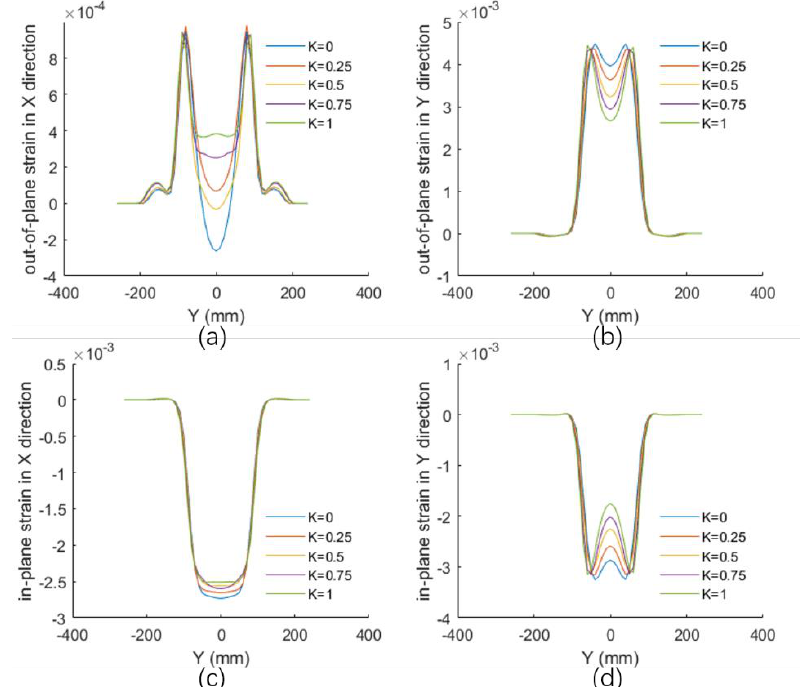
Figure 11. Plastic strain distribution with different initial curvatures in section S B –S B : ( a ) out-of-plane strain in the X direction; ( b ) out-of-plane strain in the Y direction; ( c ) in-plane strain in the X direction; and ( d ) in-plane strain in the Y direction. Table 3. Maximum relative variation.